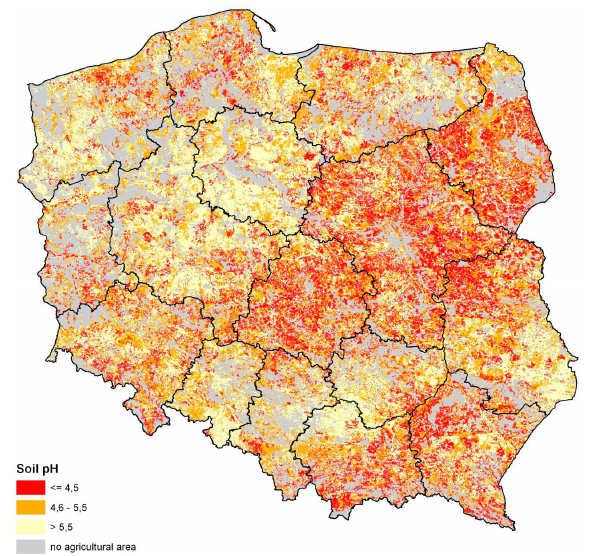
Fig. 1A. Soil acidity in Poland. The soils below pH 4.5 are very acidic and soils with pH range 4.5–5.5 are acidic according to criteria used in assessment of soils in Poland. Most of the country is covered by the areas of acid soils with pH below 5.5. Supplementary Material includes data on each category (medium and strong potential) per region in